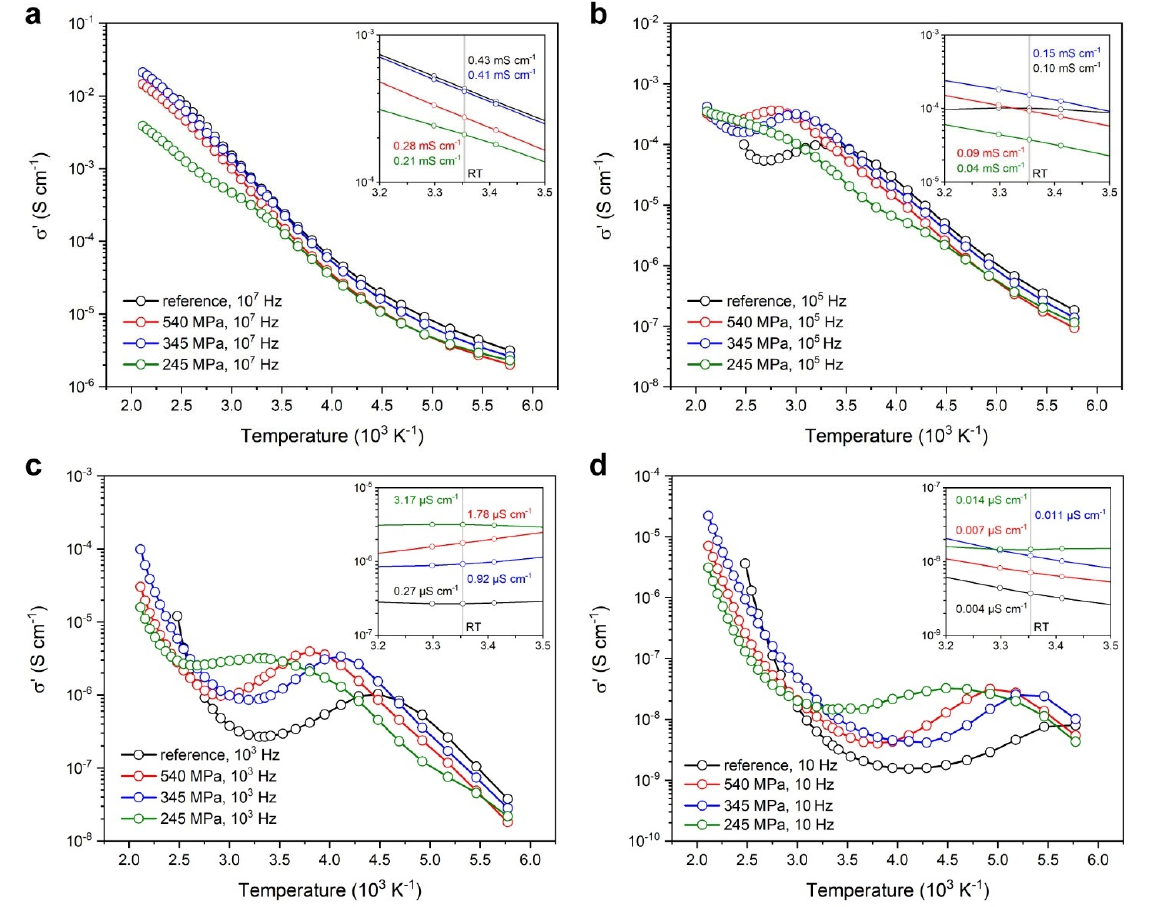
Figure 10. Arrhenius plots of the real component σ ’ of conductivity against reciprocal temperature, obtained as Poincaré sections at the frequency domains of ( a ) 10 7 Hz; ( b ) 10 5 Hz; ( c ) 10 3 Hz; and ( d ) 10 Hz. Comparative scans include all in-lab prepared NASICON pellets over different levels of applied pressure versus the commercial NASICON as the reference. Inlets portray the temperature interval in the vicinity of RT, with displayed conductivity readings for RT at the corresponding scanning frequency. Temperature dependency manifests as linearity in the ( a , b ) high-frequencies scans. Temperature dependency becomes distorted at the lower ( c , d ) frequency intervals due to polarization dominance.